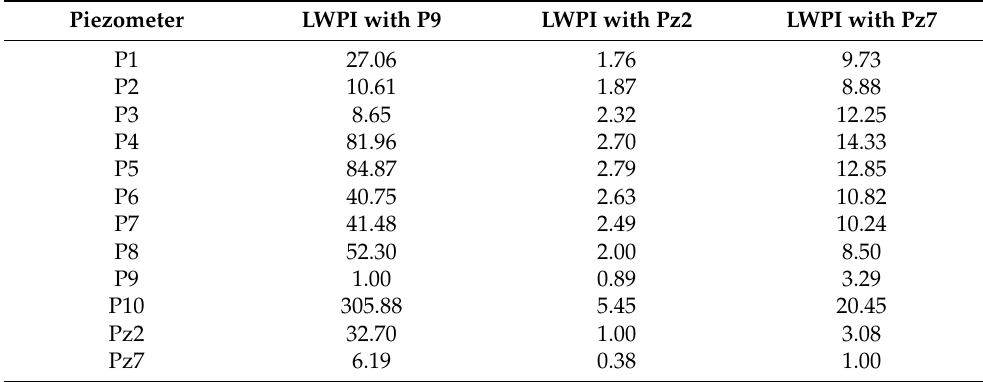
Table 4. Mean value of the LWPI index with three different piezometers taken as the hydrochemical